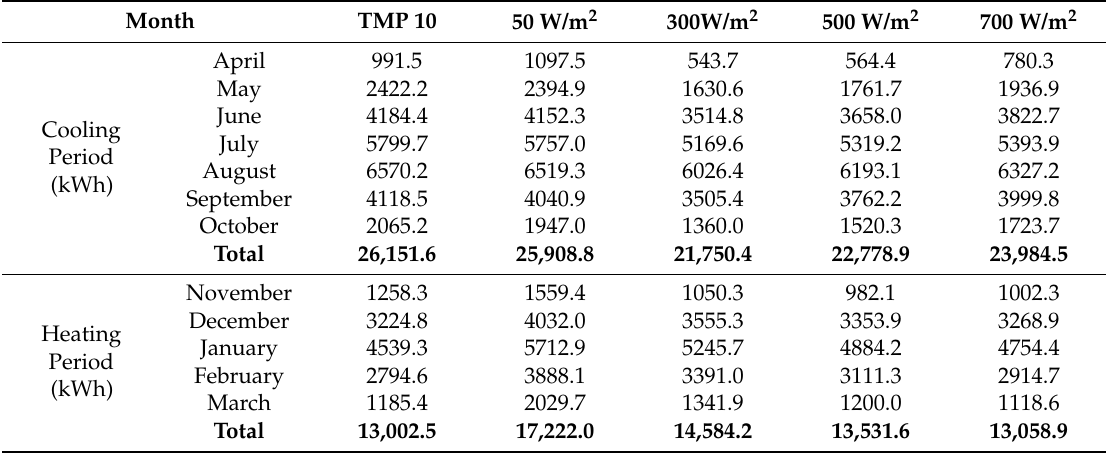
Table 9. Electrochromic glass’ controlling conditions and monthly energy consumption